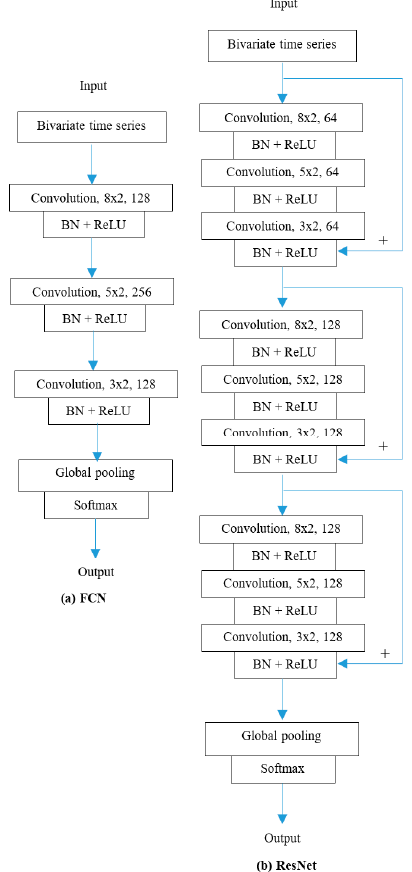
Figure 5. Network structures of FCN and ResNet.